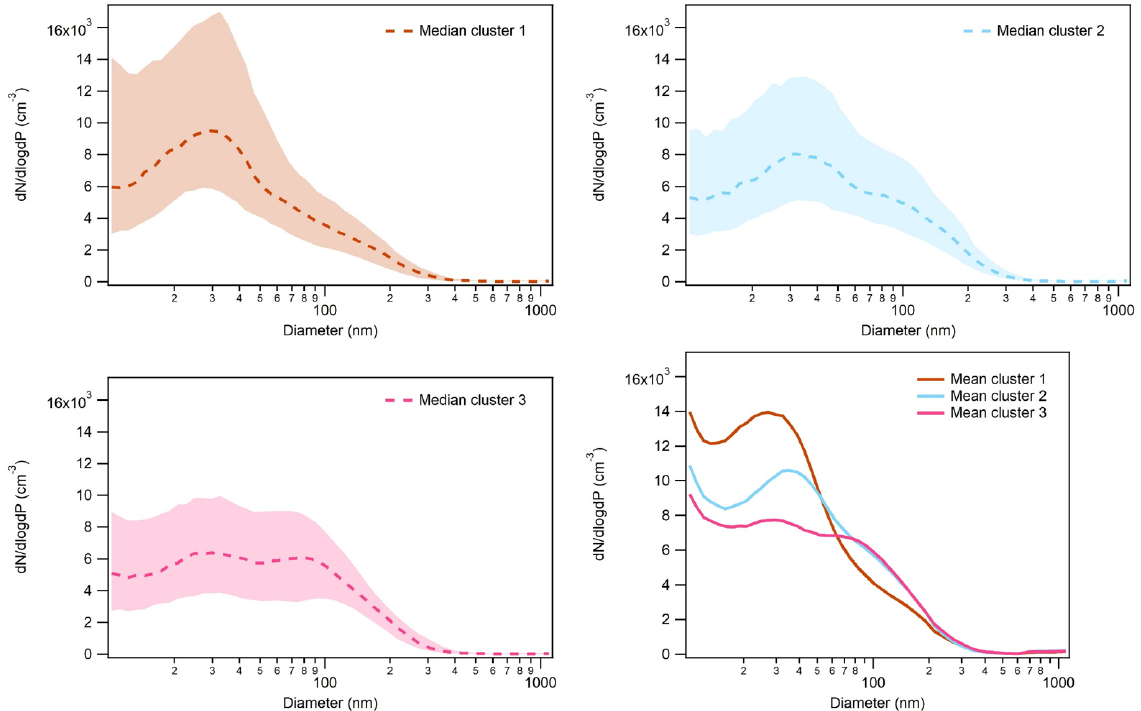
Figure 14. Number size distributions of the three clusters in the 10–1000nm range from SMPS GRIMM measurements. Dashed lines are the medians, shaded areas are the 25th and 75th percentile boundaries and solid lines are the